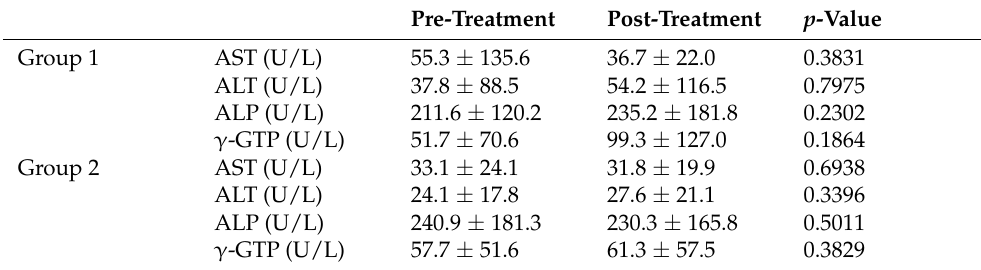
Table 3. Safety data at pre-treatment and post-treatment.